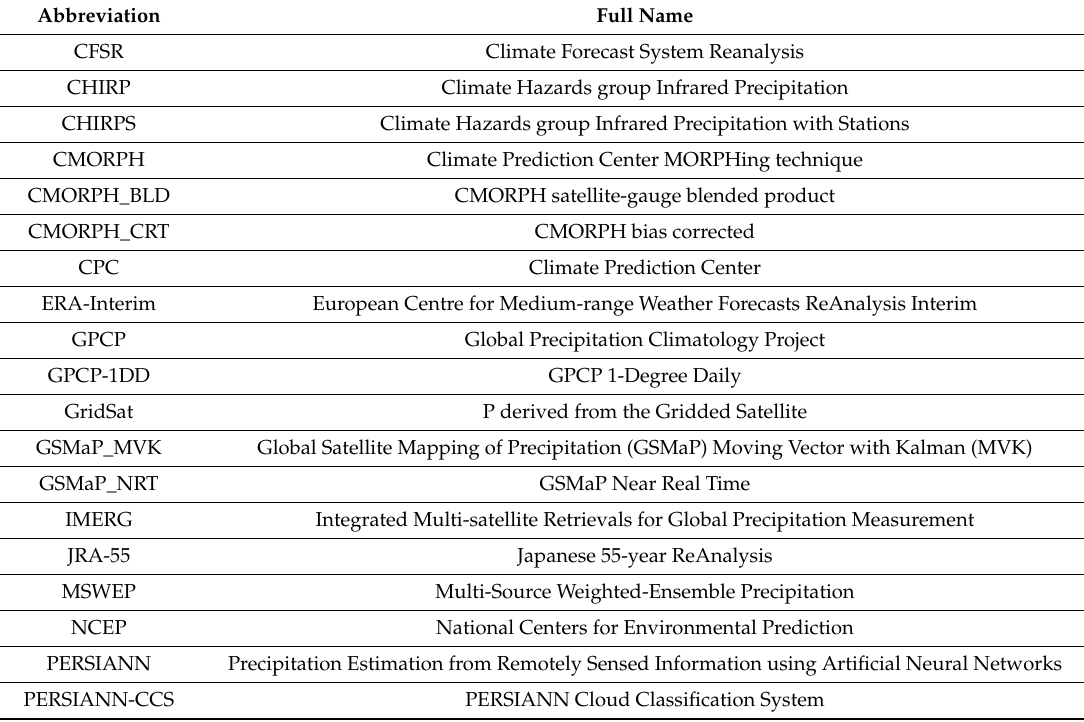
Table 1. Full name of the abbreviation in the